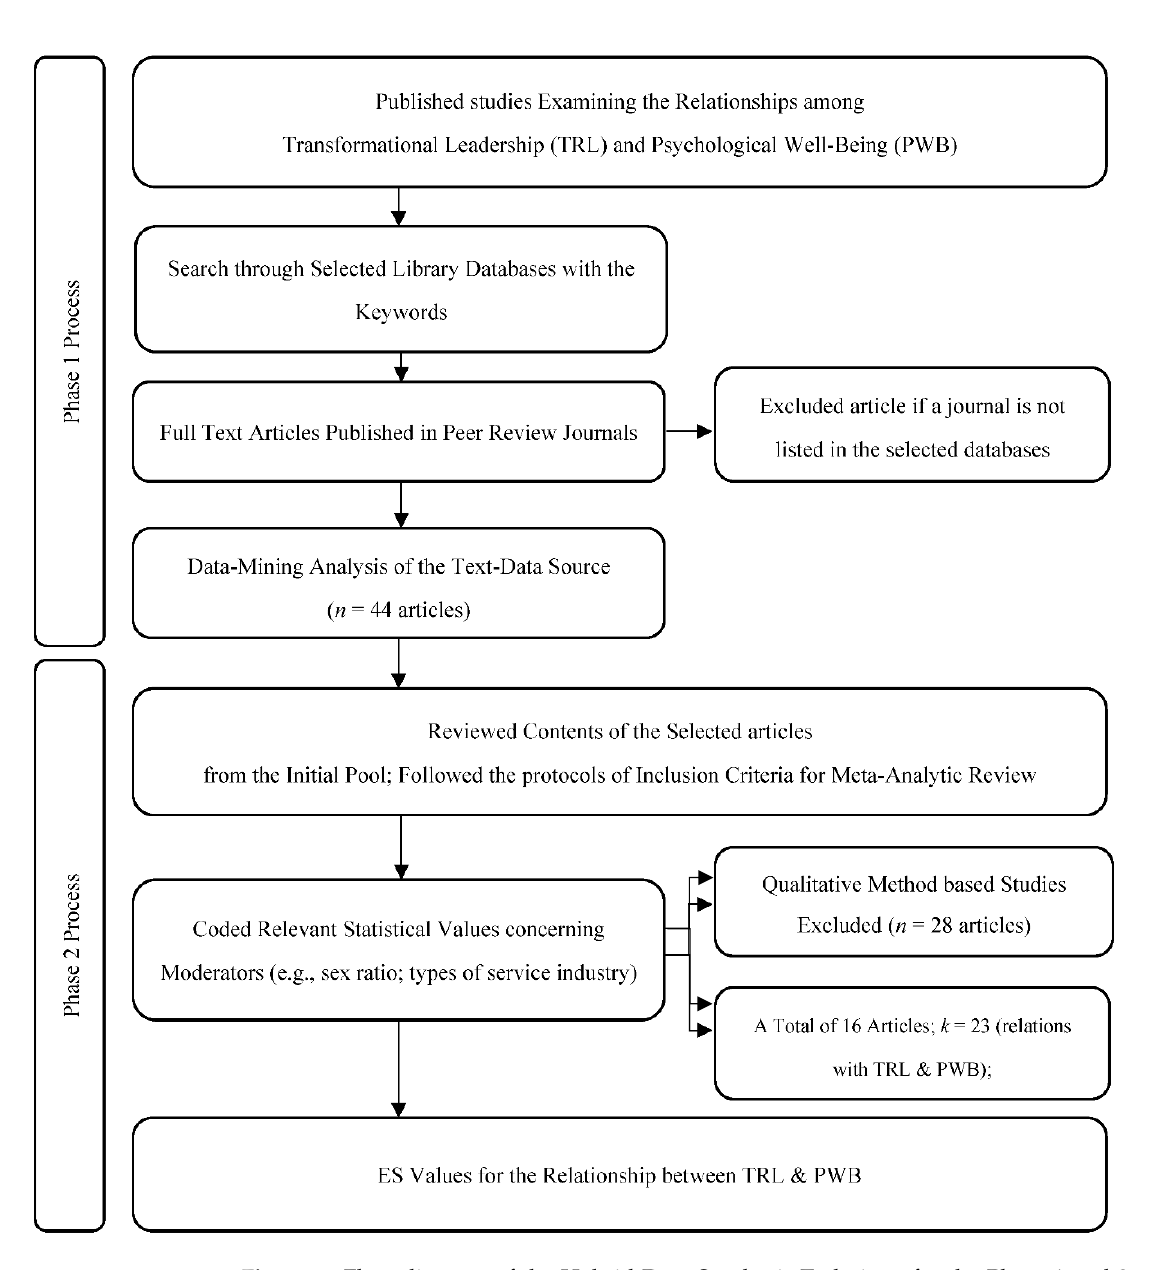
Figure 2. Flow diagram of the Hybrid Data Synthesis Technique for the Phase 1 and 2 analyses.